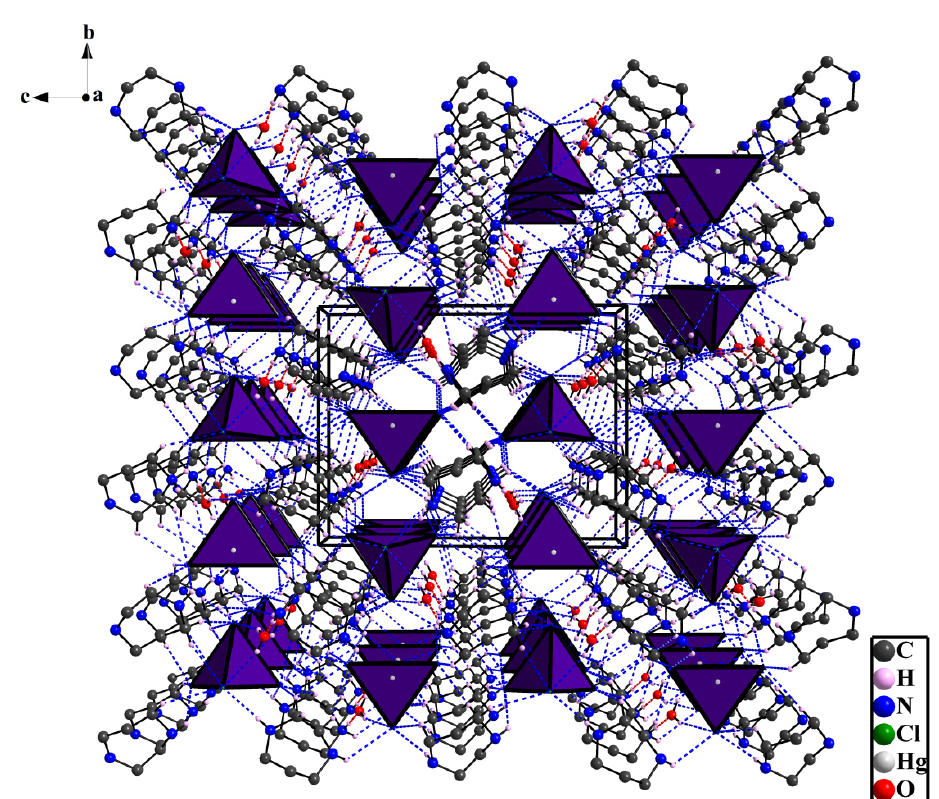
Figure 3. Perspective view of the (C 5 H 14 N 2 )[HgCl 4 ] · H 2 O compound (the red and blue lines represent hydrogen bonds).